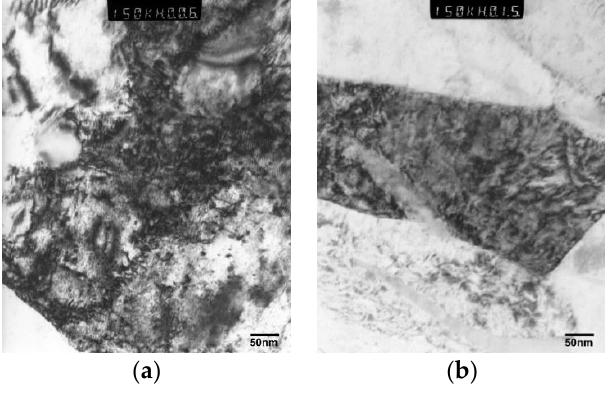
Figure 5. TEM images of untreated ( a ) and treated ( b ) EN8.